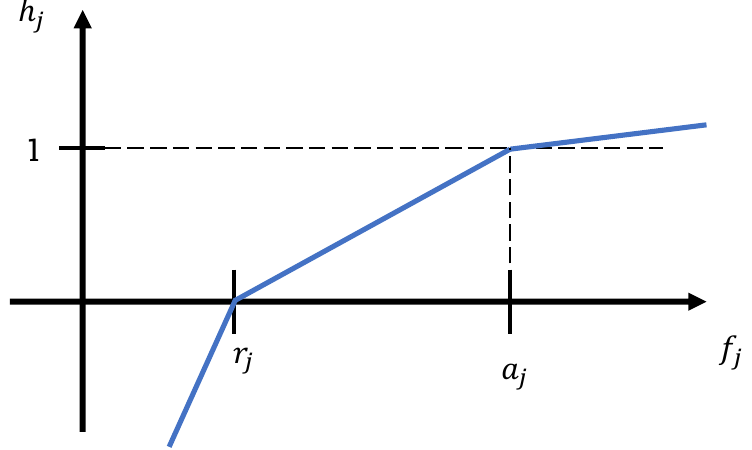
Figure 2. Partial achievement function of f j